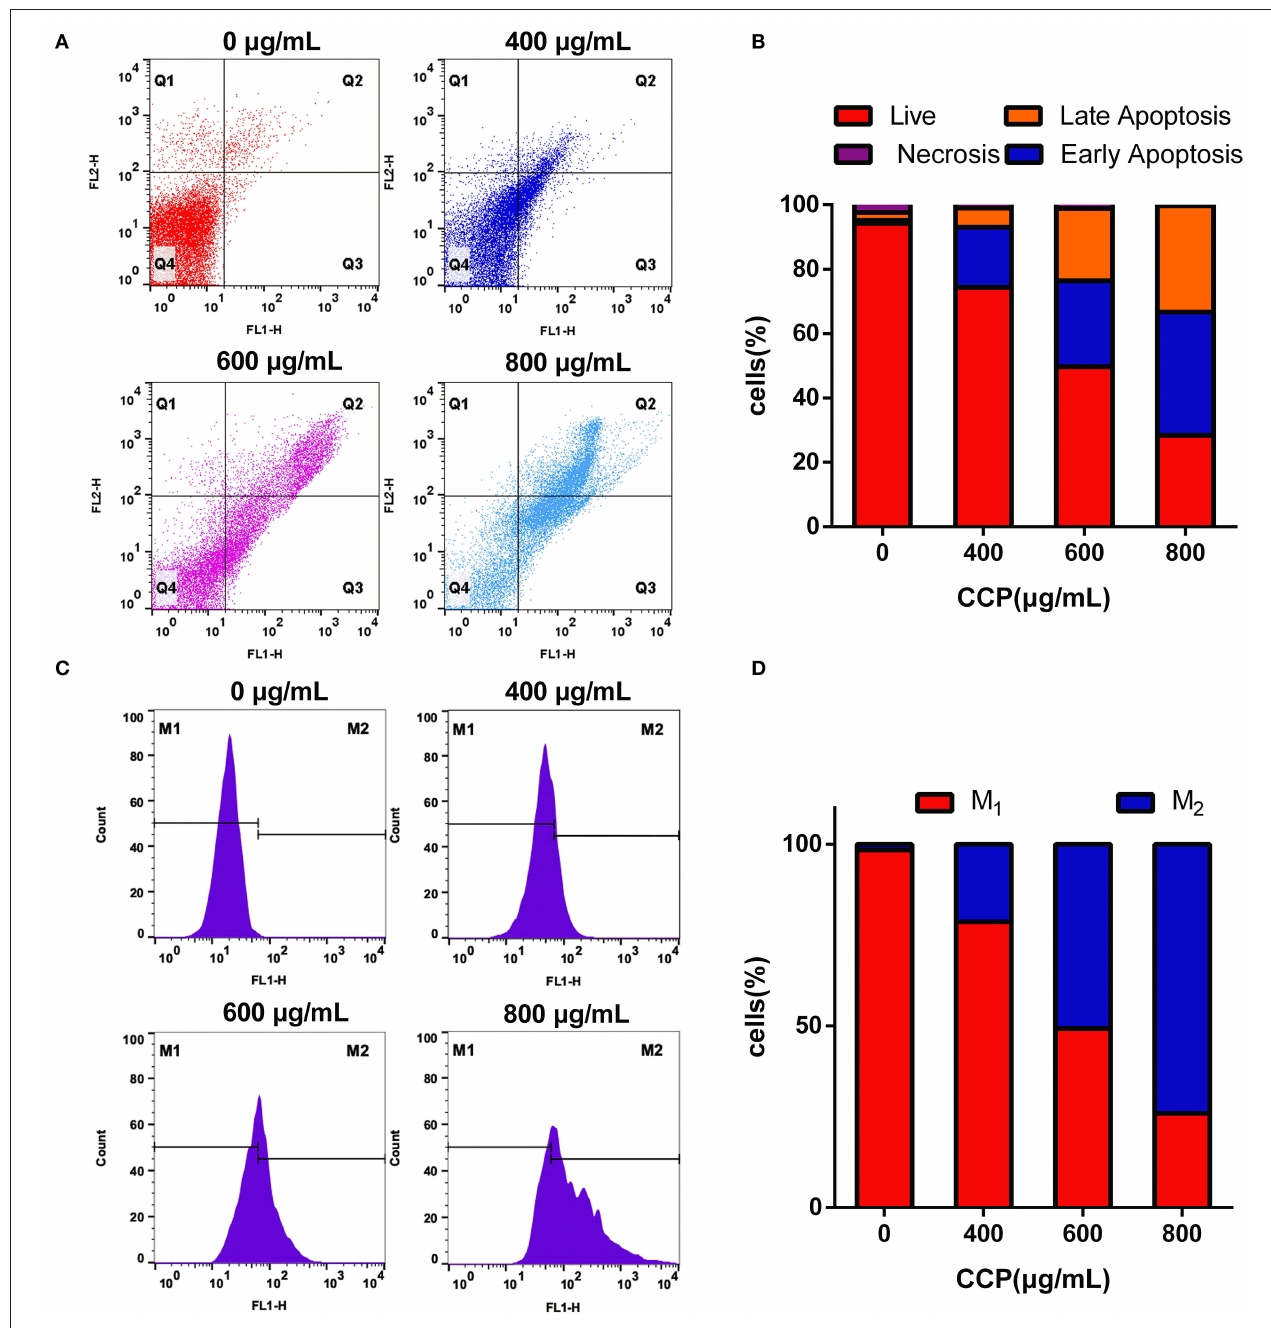
FIGURE 5 | The scatter (A) and column (B) showed the Annexin V-FITC/PI staining results. The DCFH-DA staining results (C) and quantitative analysis (D) of the intracellular ROS.